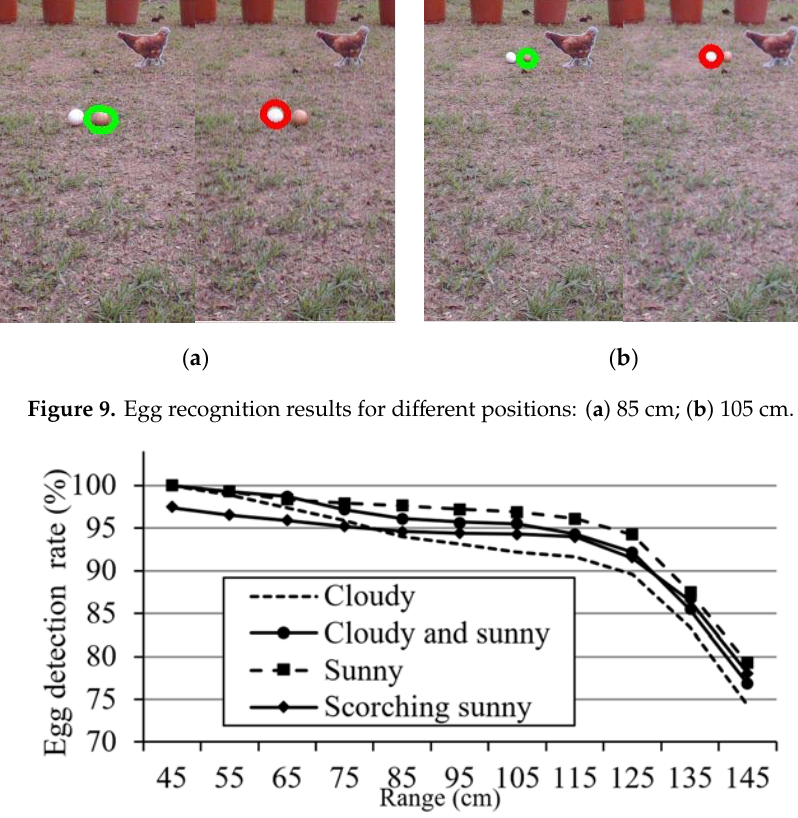
Figure 10. Egg detection results for different distances between robot and egg.